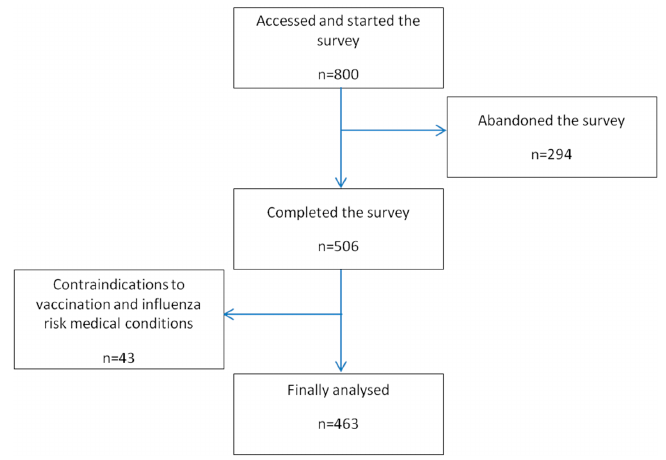
Figure 1. Flow chart of CPs’ access to and participation in the survey.